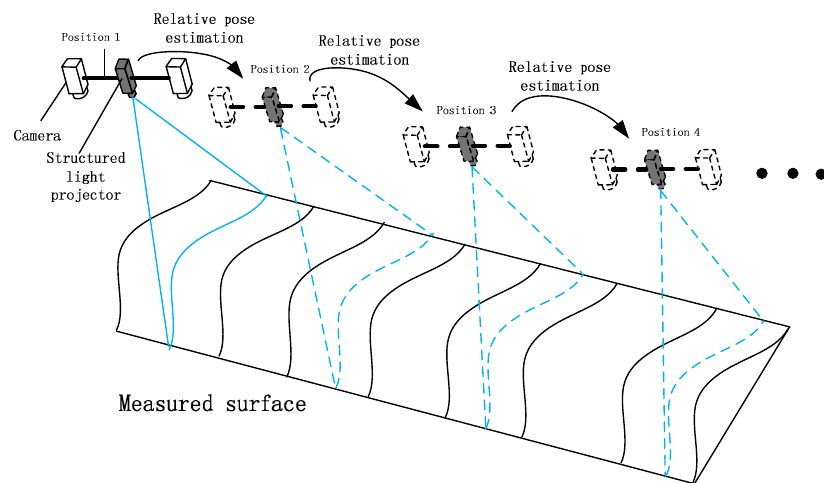
Figure 1. Schematic of surface reconstruction using push-broom structured light system.